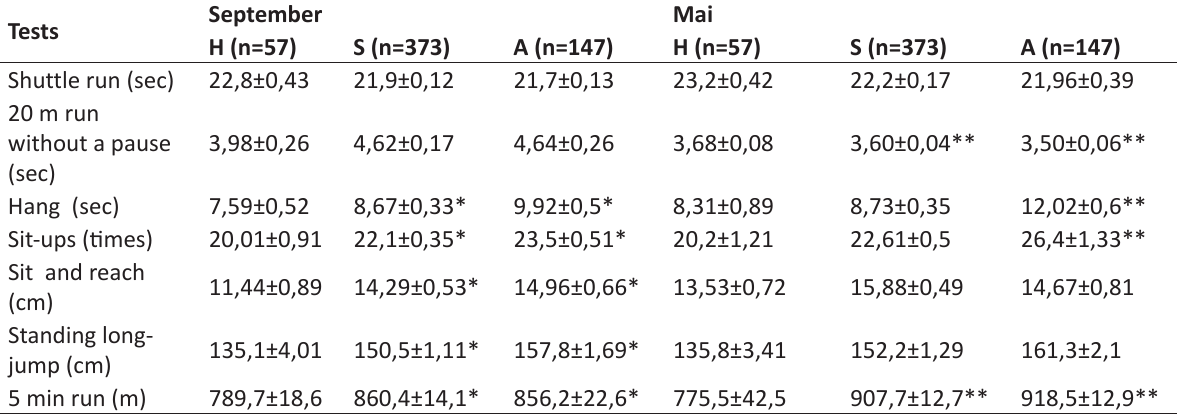
Table 1. Dynamics of parameters in motor tests in girl-students of different somatotypes